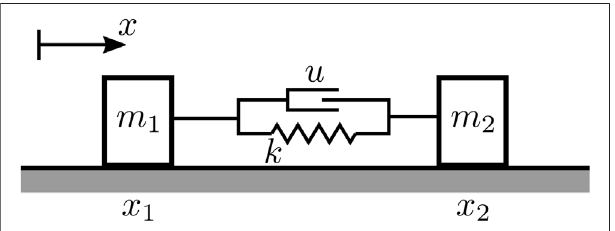
FIGURE 3 | Simpli fi ed mathematical model for the soft inchworm